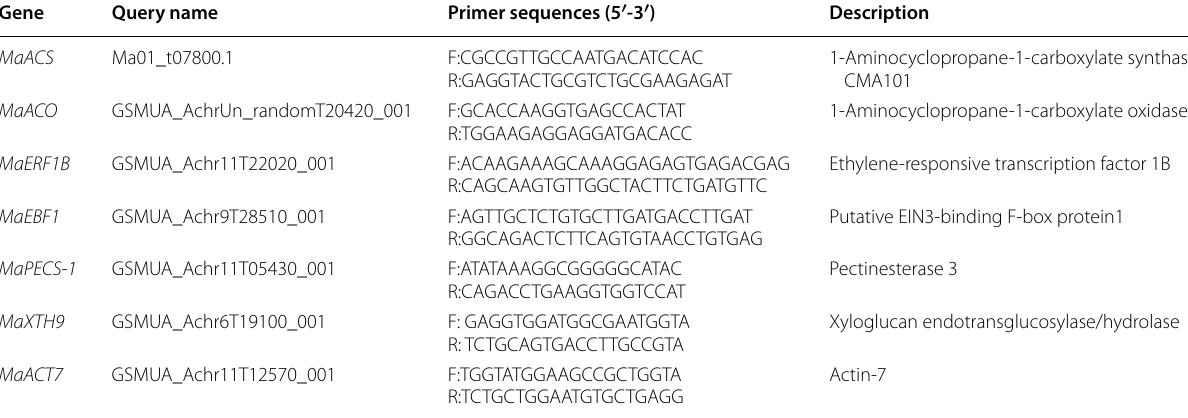
Table 1 Specific primer sequences used in this study